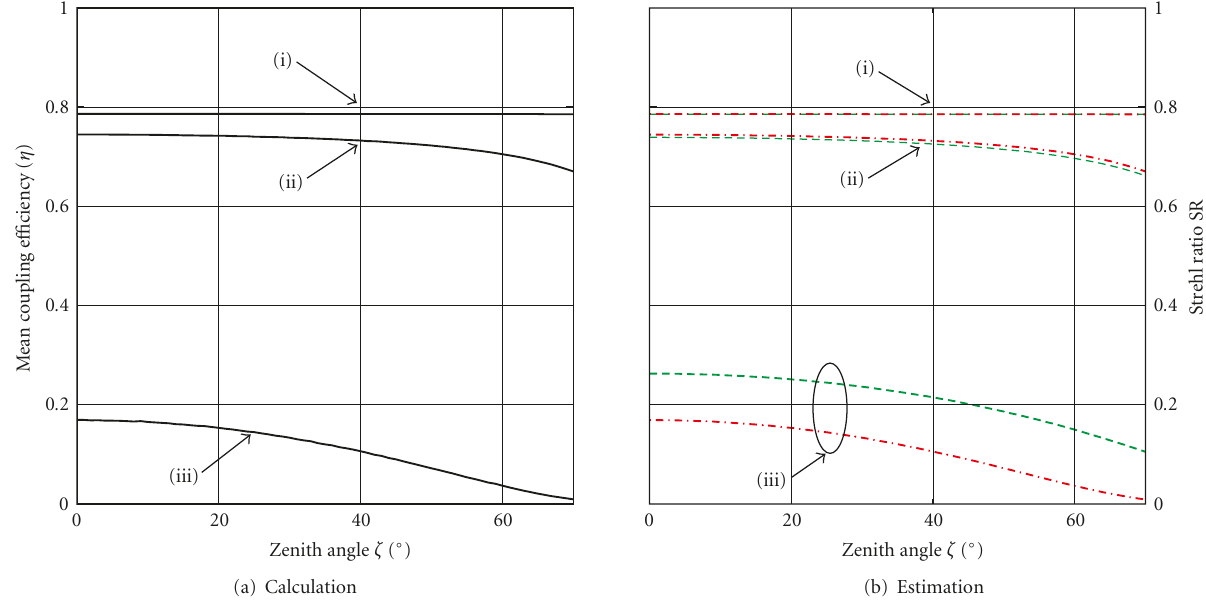
Figure 6: (a) Calculated coupling e ffi ciency (1) and (b) estimation of coupling e ffi ciency using the Strehl ratio (dashed line: (6), dashed- dotted line: (7)) versus zenith angle for three di ff erent link scenarios: (i) GEO-to-HAP with h HAP = 20km and D = 0 . 135m, (ii) GEO-to- HAP with h HAP = 2400m and D = 0 . 135m, and (iii) GEO-to-ground with h ground = 2400m and D = 1m at the